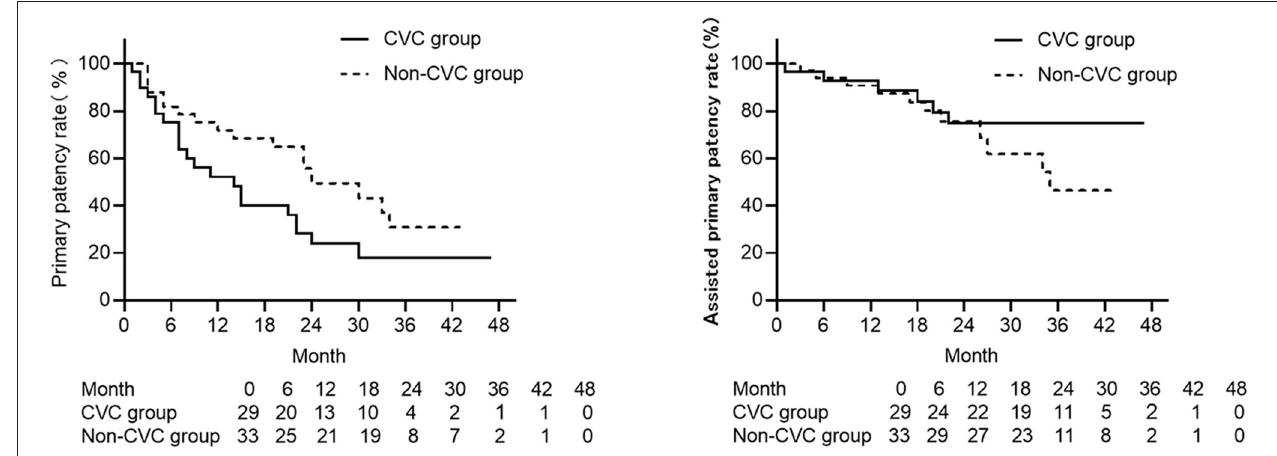
FIGURE 1 | The Kaplan–Meier curves of primary patency (left) and assisted primary patency (right) for central venous lesions with (CVC group) or without (non-CVC group) previous ipsilateral central venous catheter placement history. The CVC group is depicted with solid lines and the non-CVC group with the dotted line. The CVC group has a lower primary patency compared with the non-CVC groups ( p = 0.044), and in assisted primary patency, the non-CVC group tended to be lower after 30 months but with no significant difference ( p = 0.725).